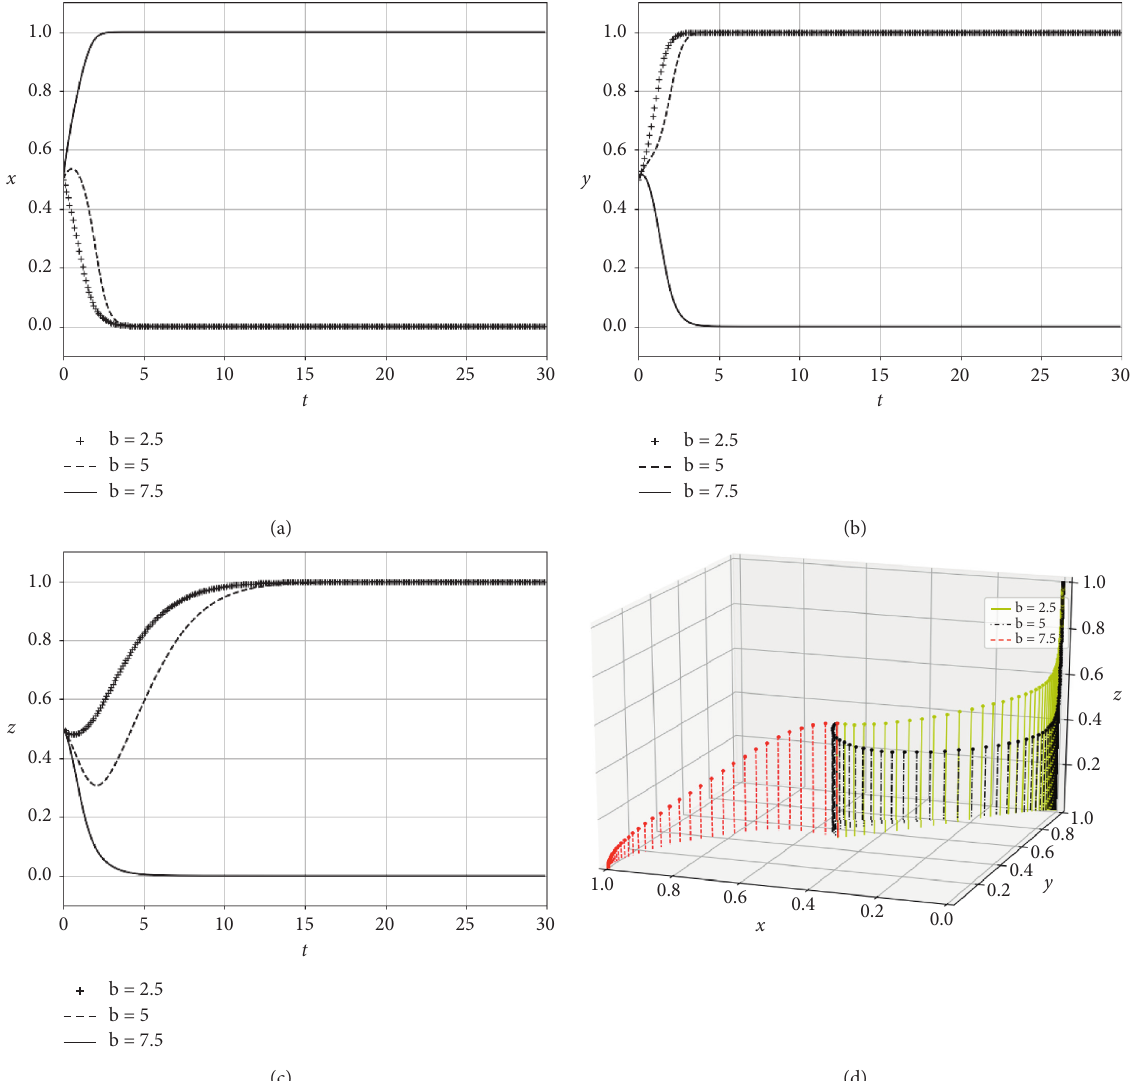
Figure 7: The evolution of the local government, the new media, and the local people, and the three parties under different levels of government intervention in